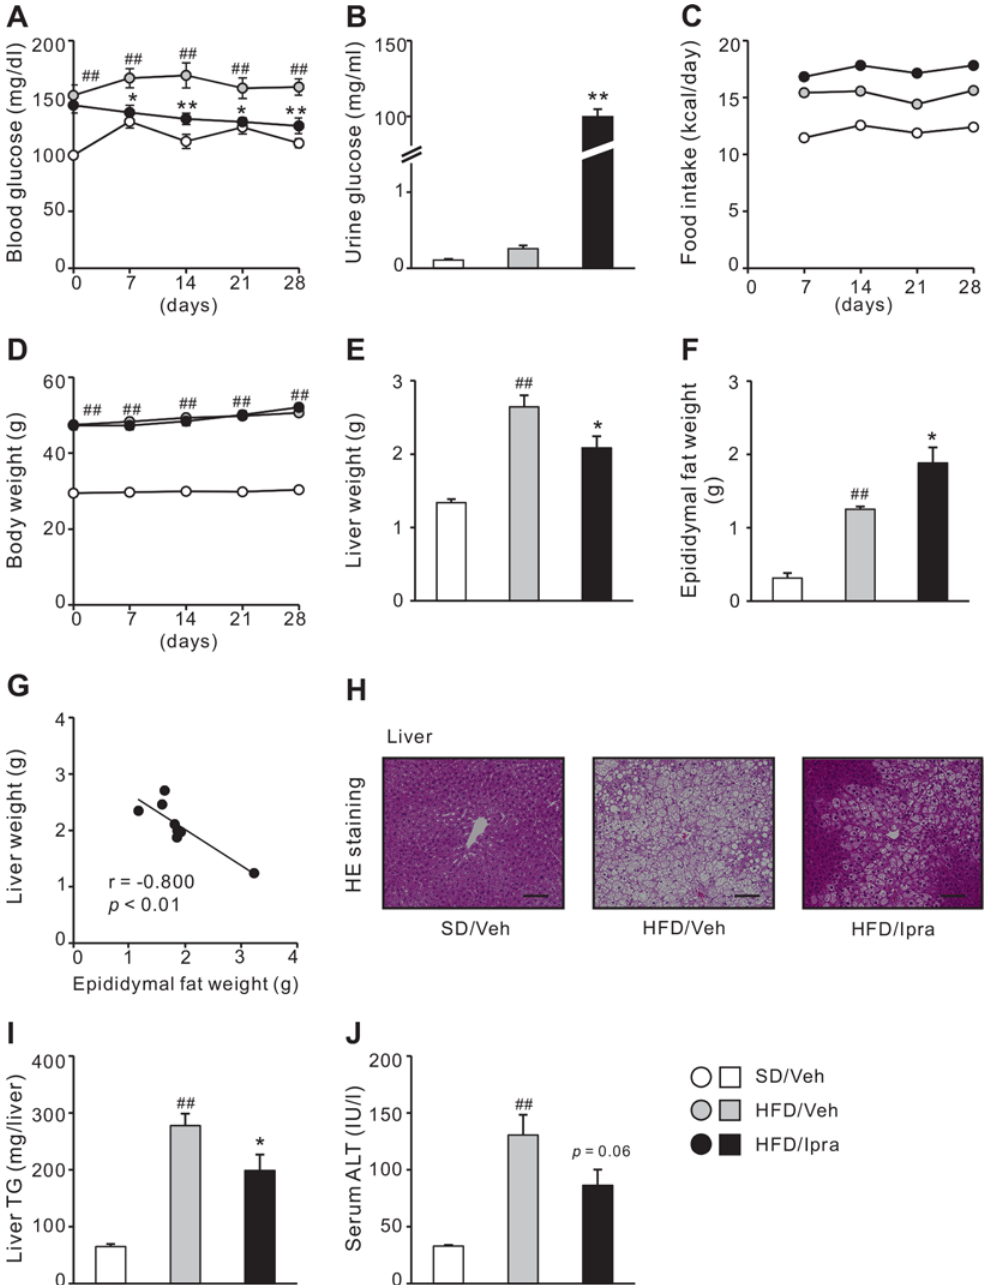
Fig 1. Metabolic characterization and hepatic steatosis of HFD-fed WT mice treated with or without ipragliflozin. Eight-week-old WT mice were fed a SD or a HFD for 16 weeks. Mice were given with the vehicle or 10mg/kg of ipragliflozin during last 4 weeks. (A) Blood glucose during ipragliflozin treatment. (B) Urine glucose concentration after 3 weeks of ipragliflozin treatment. (C) Food intake and (D) body weight during ipragliflozin treatment. Weights of the (E) liver and (F) epididymal fat after 4 weeks of ipragliflozin treatment. (G) Correlation of the liver weight with the epididymal fat weight in ipragliflozin-treated mice. (H) Hematoxylin and eosin (HE) staining and (I) triglyceride (TG) content of the liver. (J) Serum ALT levels. Veh, vehicle; Ipra, ipragliflozin. Original magnification, × 200. Scale bars, 100 μ m. # p < 0.05, ## p < 0.01 vs SD/Veh; * p < 0.05, ** p < 0.01 vs HFD/Veh. n = 6 – 8.